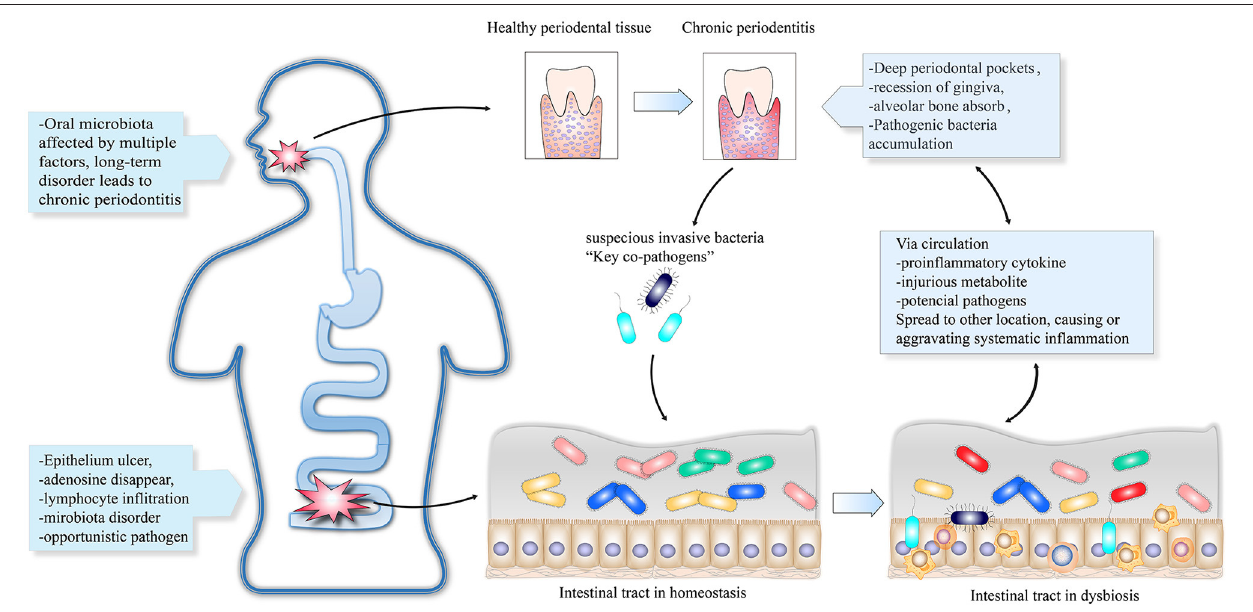
FIGURE 1 | The oral cavity and intestinal tract can contain initial lesions infected with suspicious invasive bacteria that lead to localized dysbiosis. The key pathogens can travel through the digestive tract to other parts of the body and trigger or aggravate inflammatory diseases. Other proinflammatory cytokines and harmful metabolites can be transmitted via the circulatory system to initiate